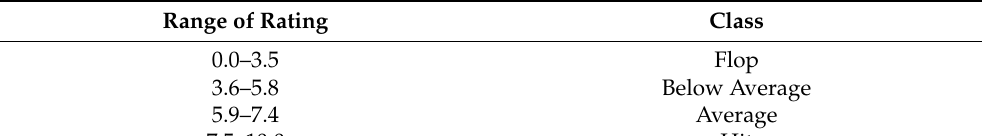
Table 2. Rating Classi fi cation.